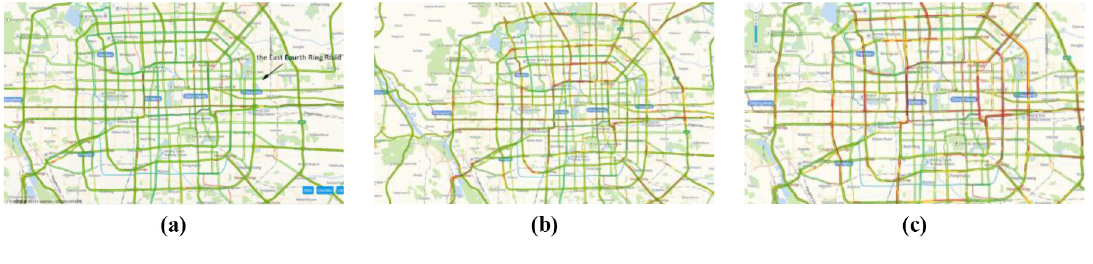
Figure 6 Distribution of traf fi c conditions in